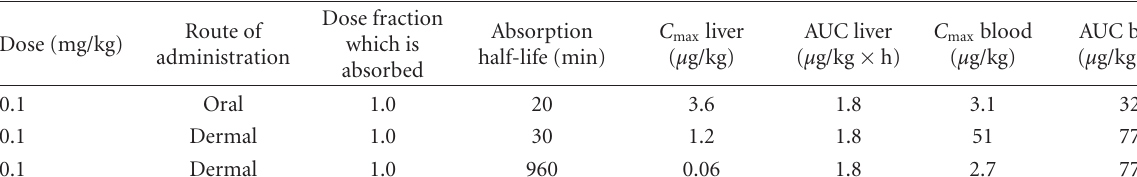
Table 3: Comparison of the peak concentrations and AUC in blood and liver after oral and dermal exposure towards coumarin. C max and AUC of coumarin were modelled in liver and in blood after 0.1 mg/kg by the oral route (extent of absorption 100%; half-life of absorption 20min) and dermal route (extent of absorption 100%; half-life of absorption 30 min and 960min dependent on the cosmetic preparation). It can be seen that the AUC in the liver is identical because the amount absorbed and reaching the liver is the same. However, because of di ff erences in the absorption half-life C max in the liver di ff ers. In blood, AUC is di ff erent due to first pass in the liver. Even if the extent of absorption is identical the amount of coumarin reaching the systemic circulation after oral exposure is lower than after dermal exposure. C max in blood depends on the rate of absorption, expressed as half-life. If half-life of dermal absorption is similar to the oral absorption (30min versus 20min), C max is higher after dermal exposure (due to first pass in the liver after oral exposure and no first pass in the skin). If half-life of dermal absorption is prolonged as compared to the oral half-life of absorption (960min versus 20 min). C max is lower. Thus, it is not only the extent but also the rate of absorption, which matters in comparing oral and dermal exposure.